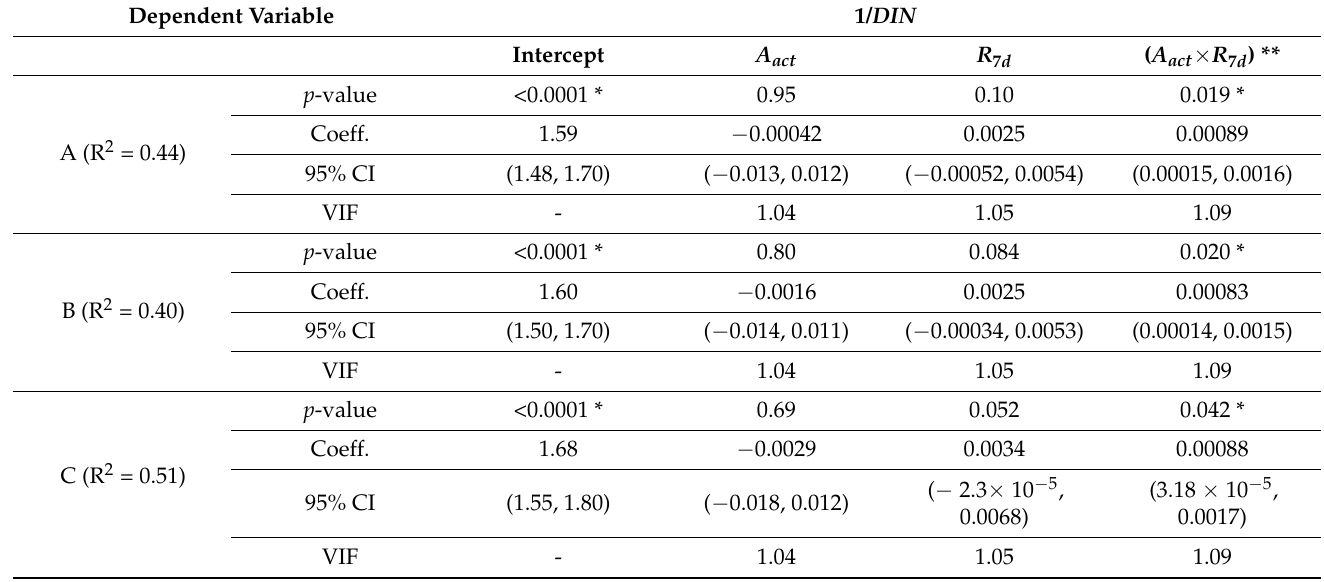
Table 9. Statistical models to predict the mean DIN concentration in the five oyster-growing